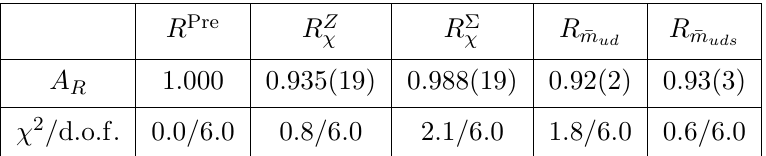
Table 15 . The (cid:12)tting results of the slope A R .